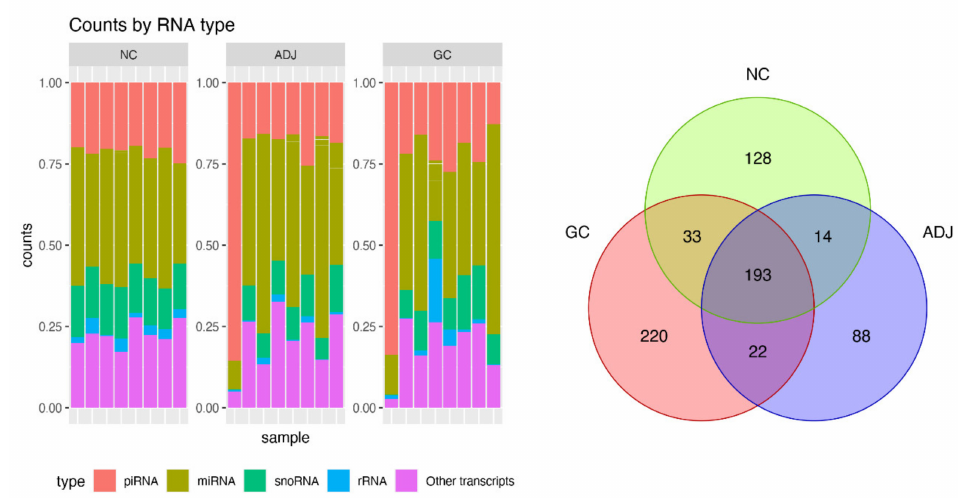
Figure 1. Summary of small RNA sequencing data. Barplot of percent of small non-coding RNA (sncRNA) transcripts identified per sample (left panel) and Venn diagram for number of PIWI-interacting RNAs (piRNAs) detected by small RNA-Seq in three groups of gastric tissue samples. Gastric cancer (CG), matched tumor-adjacent gastric tissue (ADJ) and non-cancer (NC) (right panel).